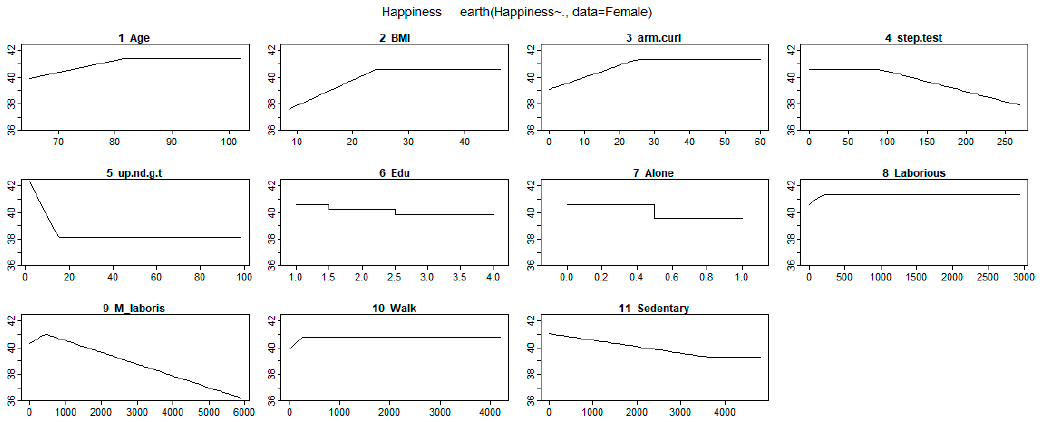
Figure 1. Trends of the effects of physical fitness and lifestyle variables on happiness among male participants. BMI—body mass index.